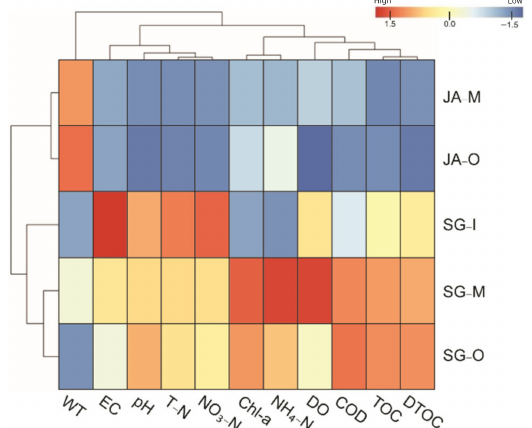
Figure 4. Star plots of IBR values for evaluating multiple gene responses in the gills ( A ) and liver ( B ) of Zacco platypus from each sampling site of Singal and Juam lakes.